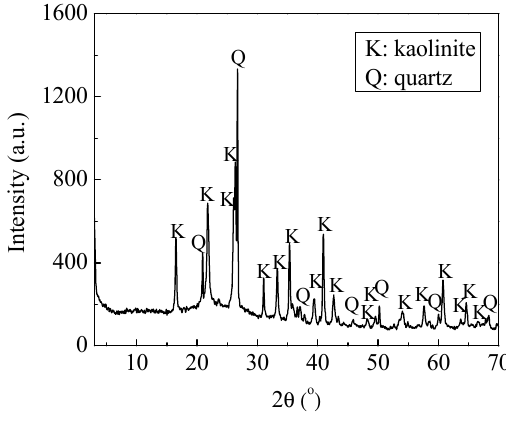
Figure 1. X-ray diffraction pattern of kaolinite. Table 1. Chemical composition of kaolinite by XRF.